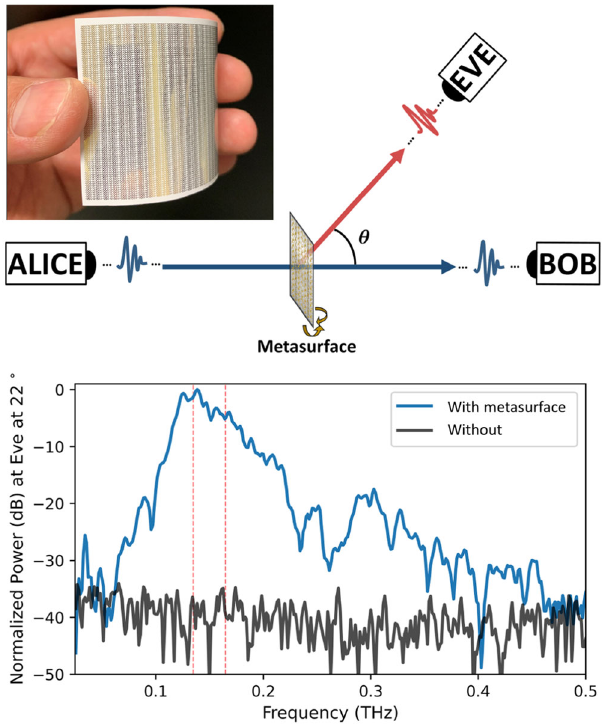
Fig. 5 | Metasurface-in-the-middle attack. A clever eavesdropper (Eve) can insert anengineeredre fl ector,suchasa fl exiblemetasurface(photo)intotheline-of-sight path between the transmitter (Alice) and the intended receiver (Bob), in order to directaportionofthespectrumtowardstheeavesdropper(upperschematic).This low-pro fi leattackwouldbe dif fi cult forAlice and Bobto detect, but woulddirecta signi fi cant signal toward Eve (lower panel). Adapted from Zhambyl Shaikhanov, Fahid Hassan, Hichem Guerboukha, Daniel Mittleman, and Edward Knightly. 2022. Metasurface-in-the-middle attack: From Theory to Experiment. In Proceedings